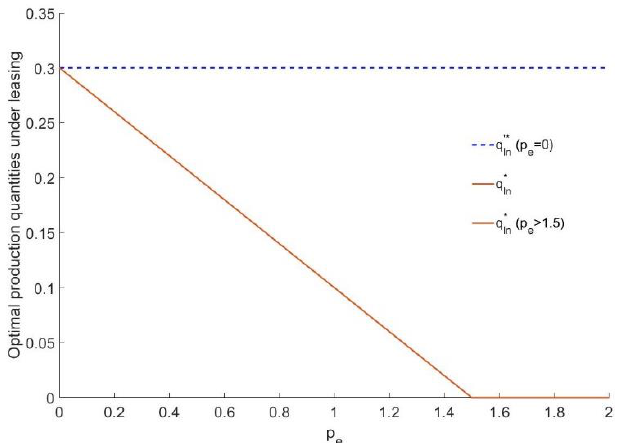
Figure 1. The relationship between the production quantities of the manufacturer and p e under a leasing strategy.